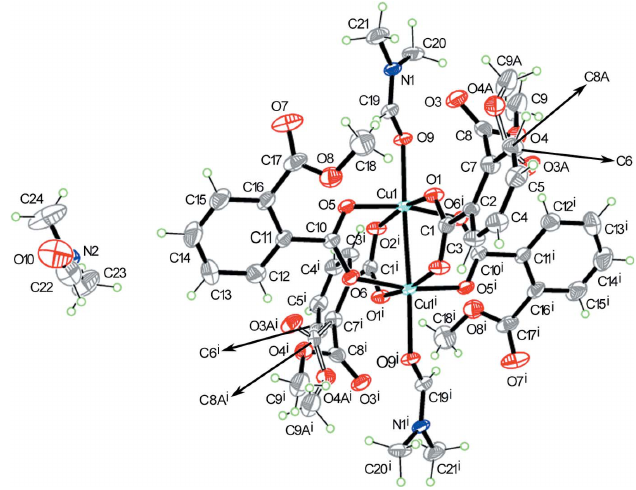
Figure 1 Molecular structure of (I) drawn with 30% probability displacement ellipsoids. Symmetry code: (i) – x + 1, – y + 1, – z +